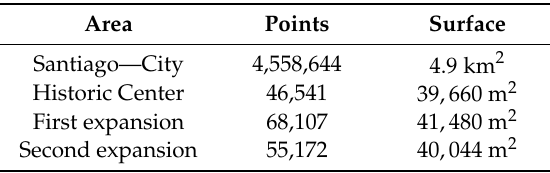
Figure 6. Case study data. ( a ) The city of Santiago de Compostela (Spain) was analyzed in order to get a qualitative measure of the performance of the methodology. Smaller samples of the point cloud were manually extracted to get quantitative measures from three easily differentiated areas within the city, the historic center (light blue), the first city expansion (light green) and the second city expansion (light red). ( b ) Point cloud data of the city. Table 1. Case study data.